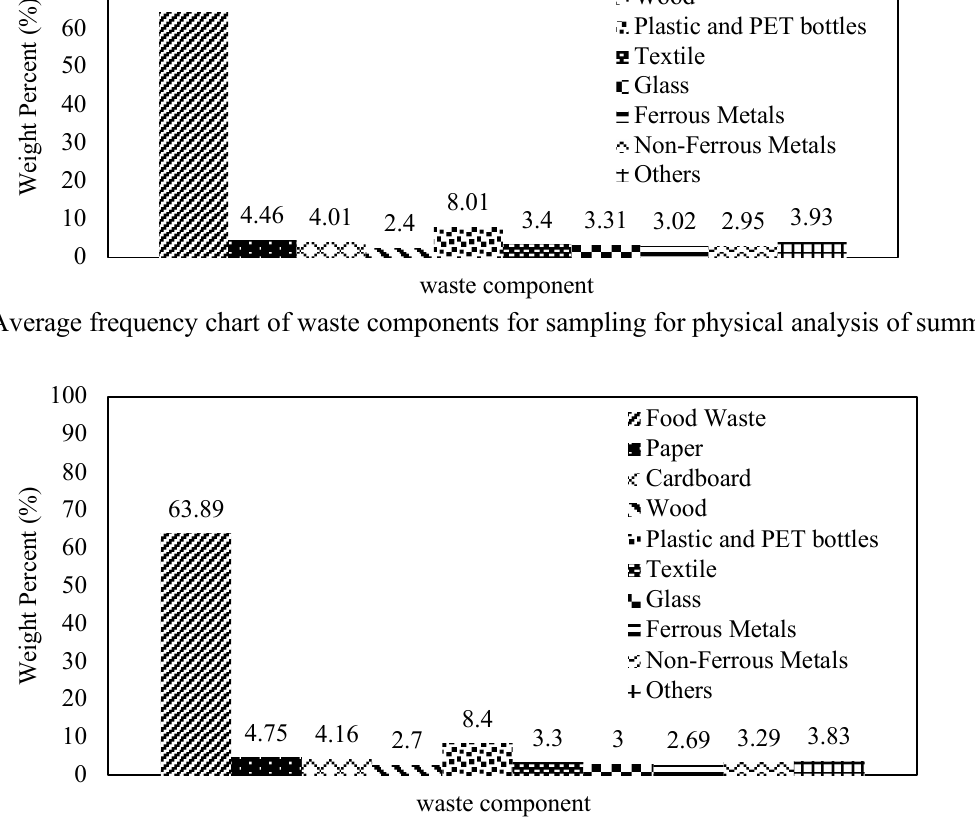
Figure 3. Average distribution chart of waste components for physical analysis of autumn